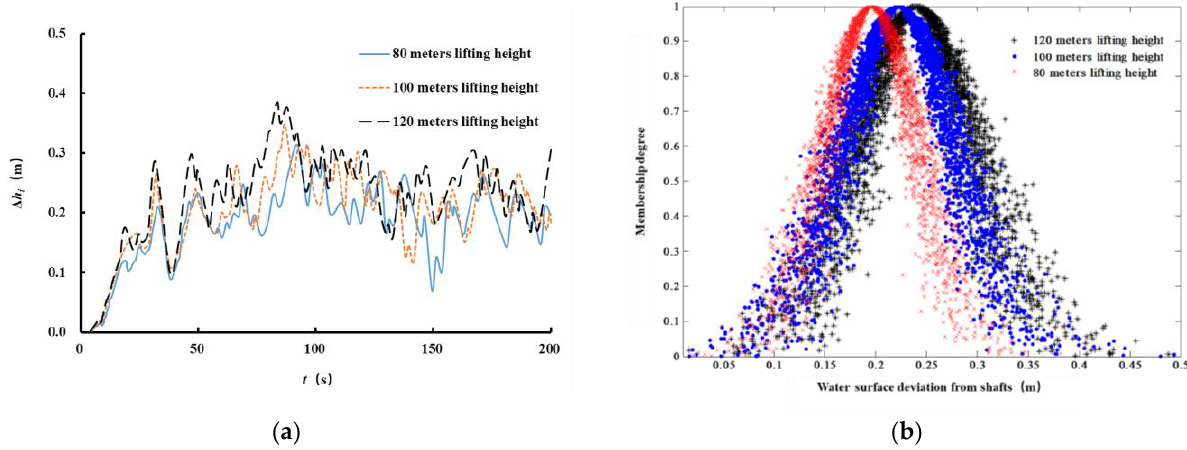
Figure 12. Water surface deviation from the shafts in the filling–emptying system with an equal inertial pipeline under 100 m lifting height: ( a ) the diagram of water surface deviation from the shafts and ( b ) the cloud model expression.